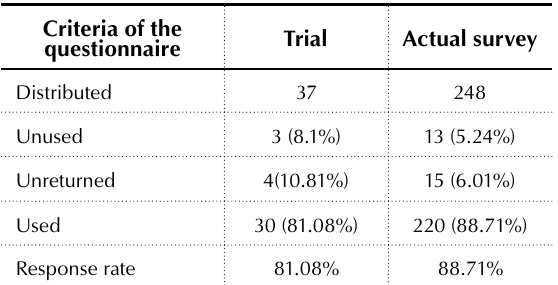
Table 1. Response rate of the survey Criteria of the